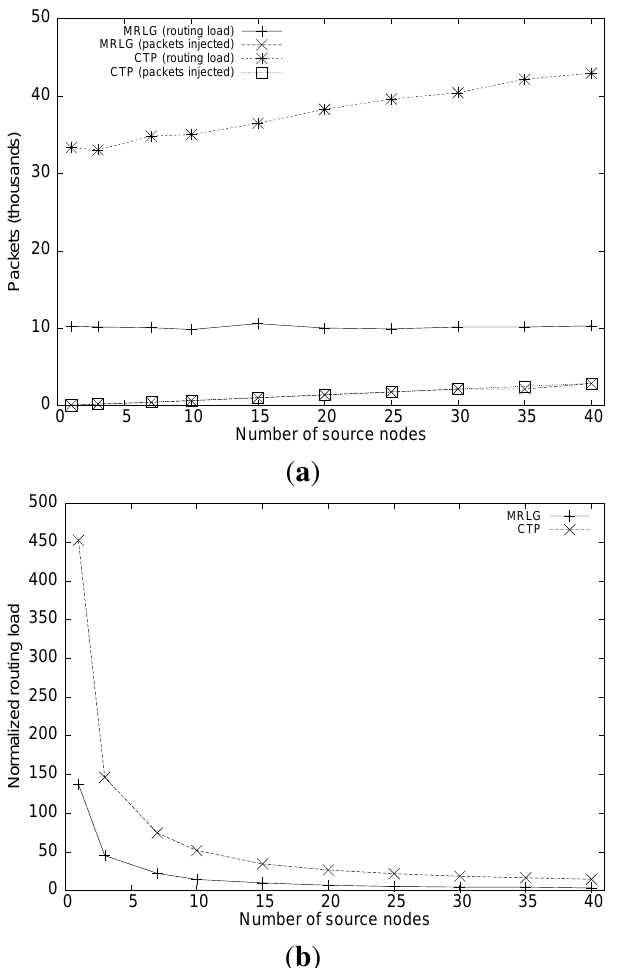
Figure 6. Varying the number of source nodes: ( a ) number of routing/injected packets, ( b )normalized routing